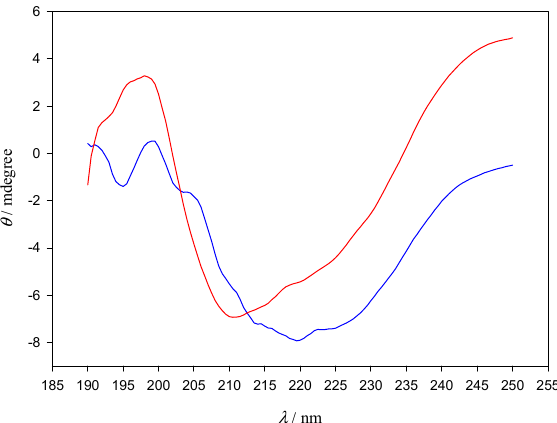
Figure 7. CD spectra of Lys in the absence (red line) and in the presence of 10 nm gold nanoparticles (blue line). [AuNPs] = 8.22 × 10 − 10 M. [Lys] = 10 − 6 M.